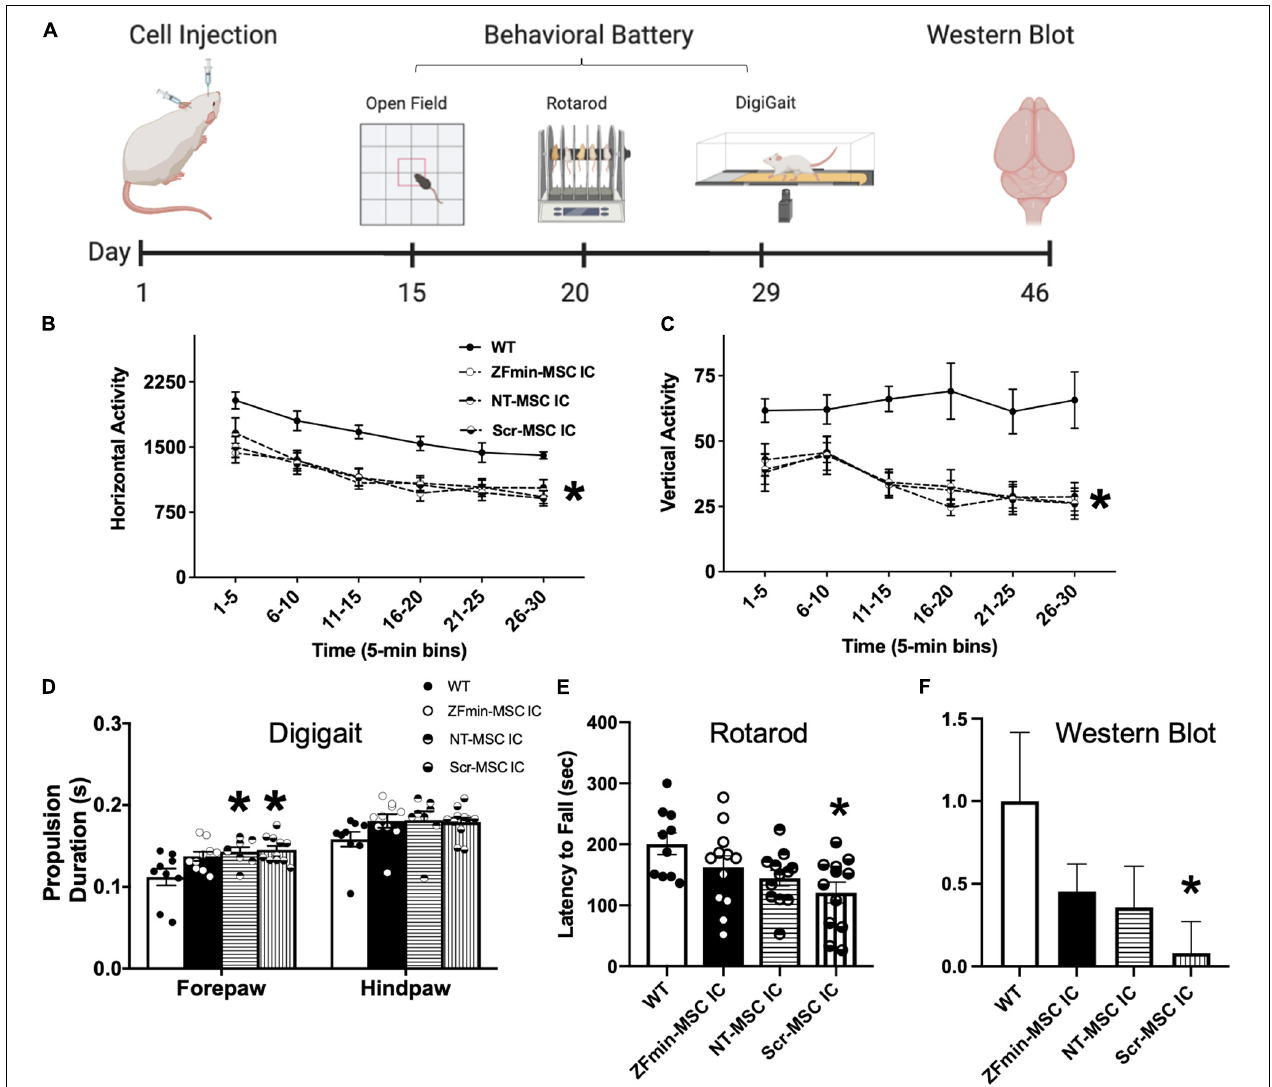
FIGURE 6 | ZF-MSC improves subtle metrics of motor behavior but not gross motor ambulation. (A) Schematic of the timeline of cell injections, recovery time, tailored motor behavioral battery for large and small effects in the motor domain in Angelman Syndrome (AS) mice, and tissue collection. (B) Ube3a mat − / pat + mice exhibited typical, robust deficits in horizontal activity and (C) vertical activity compared to WT mice. No significant differences were found in locomotion in a novel open field assessing the horizontal and vertical activity using beam breaks in a novel arena. All AS groups, NT-MSC and Scr-MSC and ZF-MSC, regardless of treatment, were different from WT in horizontal activity and vertical activity. Analyses include both males and females. Mean ± standard error of the mean (SEM) is shown. * p < 0.05, two-way repeated-measures ANOVA (B) [ F ( 4 , 53 ) = 6.286], p < 0.001; (C) [ F ( 4 , 53 ) = 8.475]; p < 0.0001, the main effect of the treatment group followed by Sidak’s multiple comparison test. (D) Abnormal gait has been shown in Ube3a mat − / pat + mice and rats. While treadmill walking, the Scr-MSC and NT-MSC treated Ube3a mat − / pat + mice demonstrated significantly slower forepaw propulsion as compared to WT-littermates. Two-Way ANOVA [ F ( 3 , 34 ) = 3.949], p < 0.02; followed by Sidak’s Multiple Comparison Test. (E) Scr-MSC IC treated Ube3a mat − / pat + mice had significantly lower latencies to fall off the rotarod compared to WT, corroborating the finding in 6B. Two-Way ANOVA [ F ( 3 , 42 ) = 3.798], p < 0.02, a Sidak’s Multiple Comparison test could not confirm that performance of ZFmin-MSC IC animals was different from WT or control groups ( p > 0.05). (F) Western Blot analysis of Ube3a mat − / pat + AS mice showed a significant difference in UBE3A protein expression in NT-MSC and Scr-MSC negative controls compared to WT mice, but not in ZFmin-MSC treated mice. One-Way ANOVA [ F ( 3 , 41 ) = 2.092] followed by Fisher’s LSD, * p < 0.05 from WT. Error bars indicate ± standard error of the mean. Dots indicate individual mice. n = 9–12 animals per